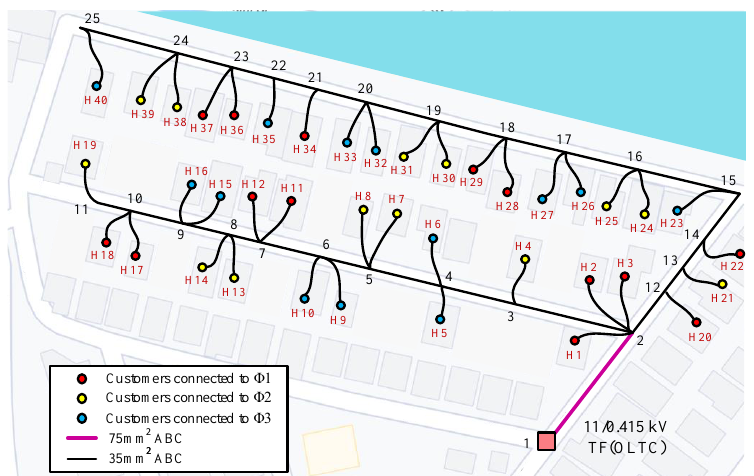
Figure 3. Single line diagram of the low voltage distribution network (Lotus Grove, Sri Lanka) used for the simulations.